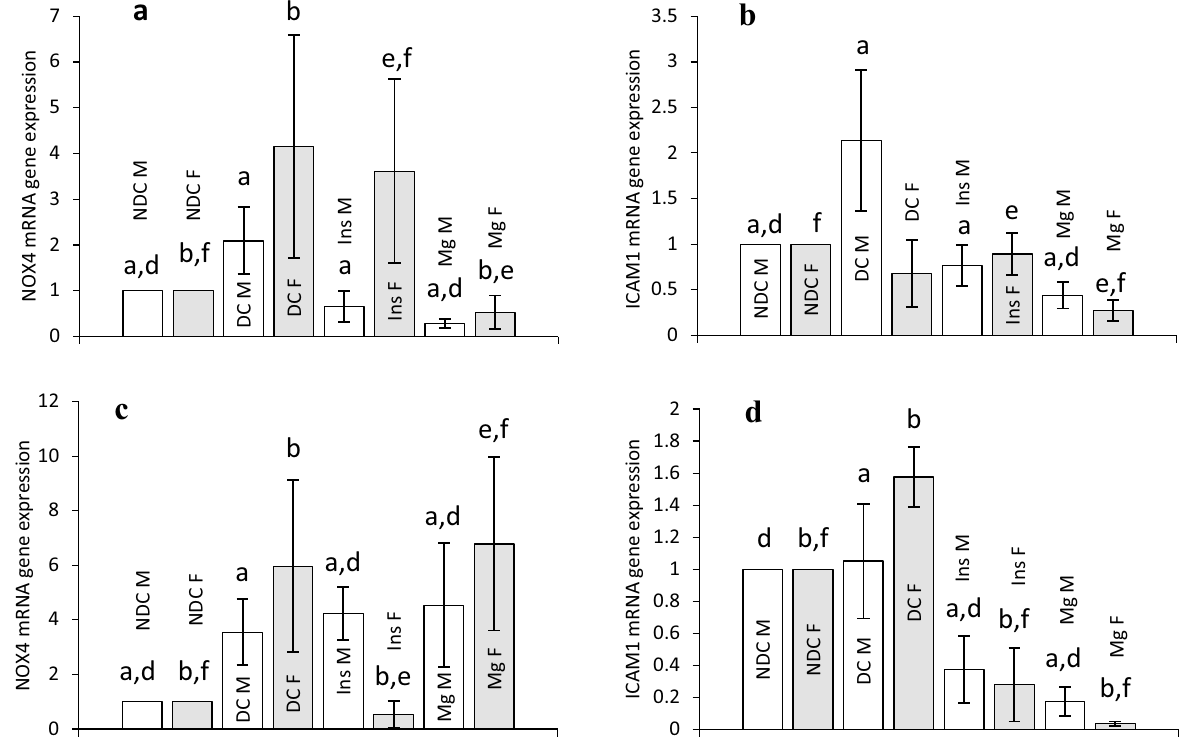
Figure 7. Comparison of NOX4 mRNA gene expression in male and female parents and their male and female offspring ( a and c respectively) and ICAM1 mRNA gene expression in male and female parents and their male and female offspring ( b and d respectively) in non-diabetic control group (NDC) was fed with normal diet, diabetic group received high-fat diet and 35 mg/Kg STZ (D), diabetic animals treated with insulin (2.5 U/Kg two time per day) (Ins) and diabetic animals treated with 10 g/l magnesium sulfate via drinking water (Mg). 10 rats in each group and data are expressed as mean ± SEM. ( a ) Significant difference between D male group and other male groups ( P < 0.0001). ( b ) Significant difference between D female group and other female group ( P < 0.001). ( d ) Significant difference between male NDC and male Mg and male insulin groups ( P < 0.001). ( e ) Significant difference between female Mg group and female insulin group ( P < 0.001). ( f ) Significant difference between female NDC and female Mg and female insulin groups ( P <